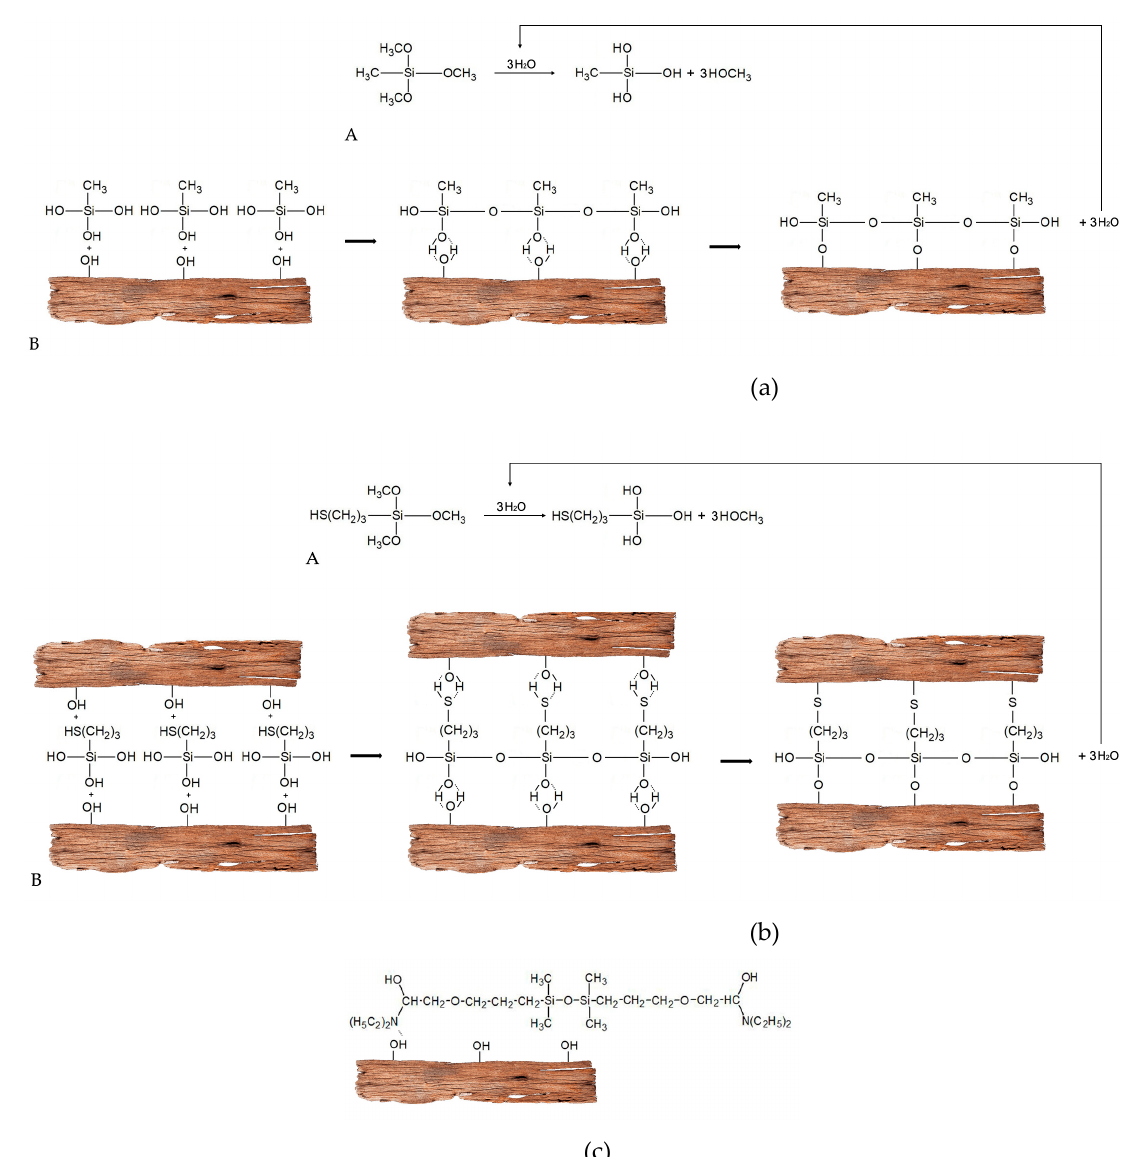
Figure 8. Schematic illustration of possible interactions taking place between the wood structure (hydroxyl groups present in the cell wall polymers) and the organosilicon compounds used ( a - c ); (A) hydrolysis of silane, (B) a set of consecutive steps of a condensation reaction.